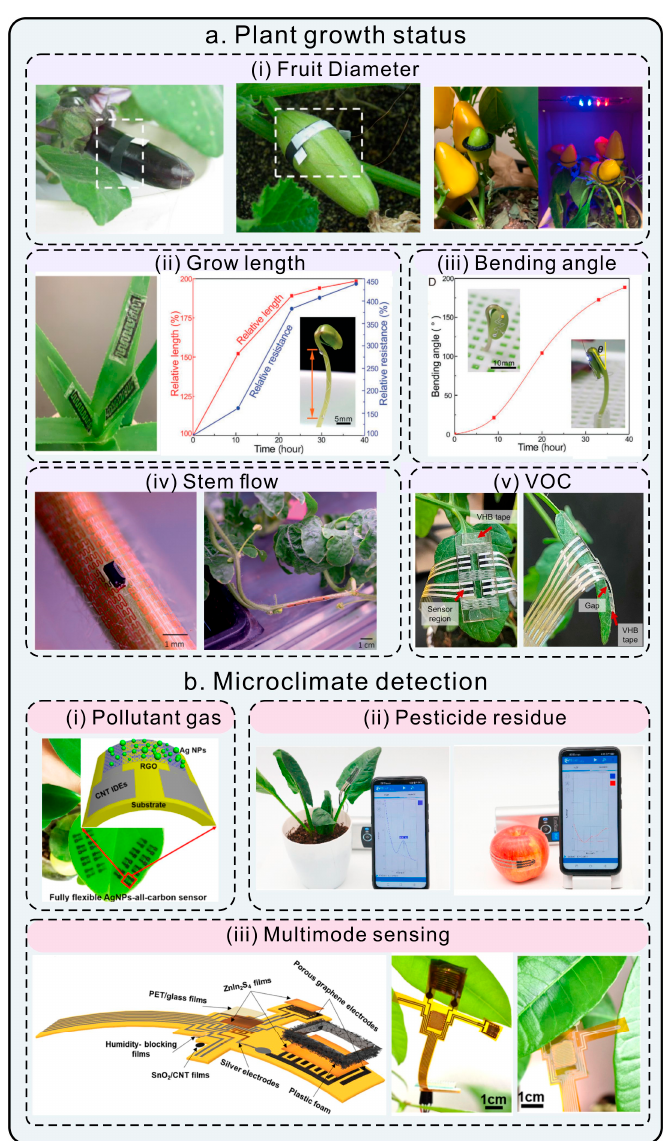
Figure 4. Soft film sensors for plant physiological detection. ( a ) Detections of plant growth status. (i) Fruit diameter detection. Left and middle are reproduced with permission from [160], copyright © 2019, Elsevier. Right is reproduced with permission from [161], copyright © 2021, Elsevier. (ii) Grow length detection. Left is reproduced with permission from [161], copyright © 2021, Elsevier. Right is reproduced with permission from [16], copyright © 2020, Wiley-VCH GmbH). (iii) Monitoring the sprout’s bending angle (reproduced with permission from [16], copyright © 2020, Wiley-VCH GmbH). (iv) Sensors for recording plant stem flow (reproduced with permission from [15], copyright © 2021, Wiley-VCH). (v) Detection of leaves releasing VOCs (reproduced with permission from [63], copyright © 2021, Elsevier). ( b ) Detection of the microclimate around plants. (i) Detection of pollutant gas surrounding leaves (reproduced with permission from [19], copyright © 2018, American Chemical Society). (ii) In situ analysis of pesticide residue on crop surfaces (reproduced with permission from [52], copyright © 2020, Elsevier). (iii) Multimode sensing for diverse environment parameters, including light, temperature, and humidity (reproduced with permission from [76], copyright © 2020, American Chemical Society). Left: schematic of the detailed device structures with different functional components. Middle and right: back and front sides of a multimodal flexible sensor device attached on the bottom side of a